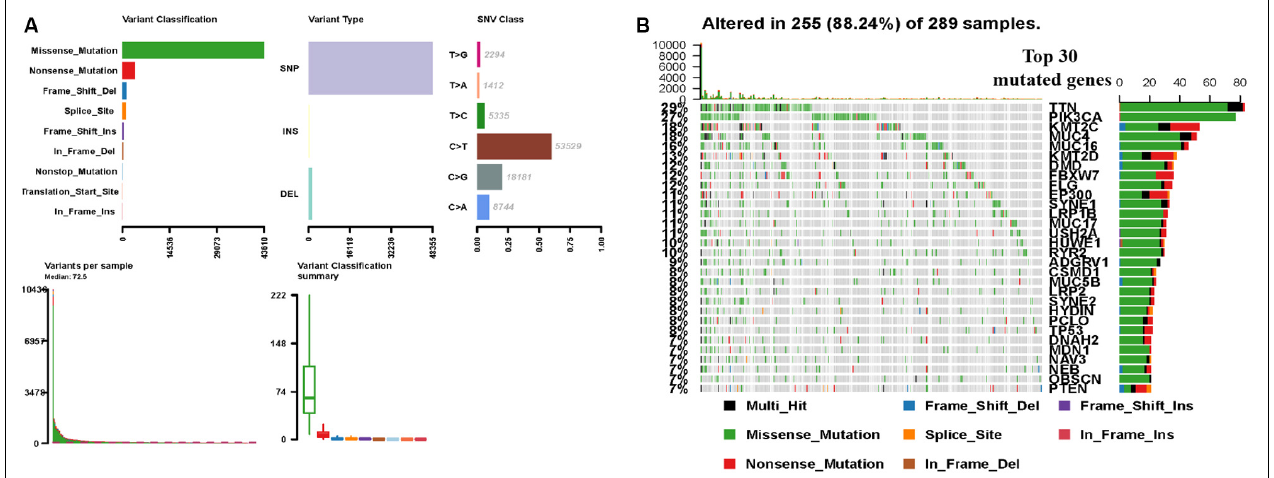
FIGURE 1 | TCGA CCC mutation cohort ( n = 289). (A) Overview of TGCA CCC cohort mutations, including variant classification, variant type, class of SNV, variants in each sample, and variant classification summary. (B) Waterfall plot of the top genes commonly mutated in the TCGA CCC cohort, in which the row represents the gene that affects the most frequent mutation in TCGA and the list represents the sample. Different types of genomic changes are represented by different colors. CCC, cervical cell carcinoma. SNV, somatic mutation.